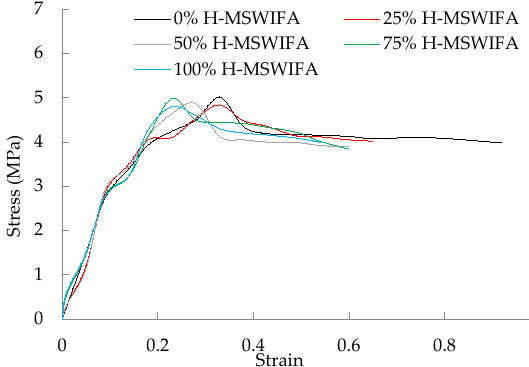
Figure 7. FSFE curve of asphalt mastic at F/A of 0.6.